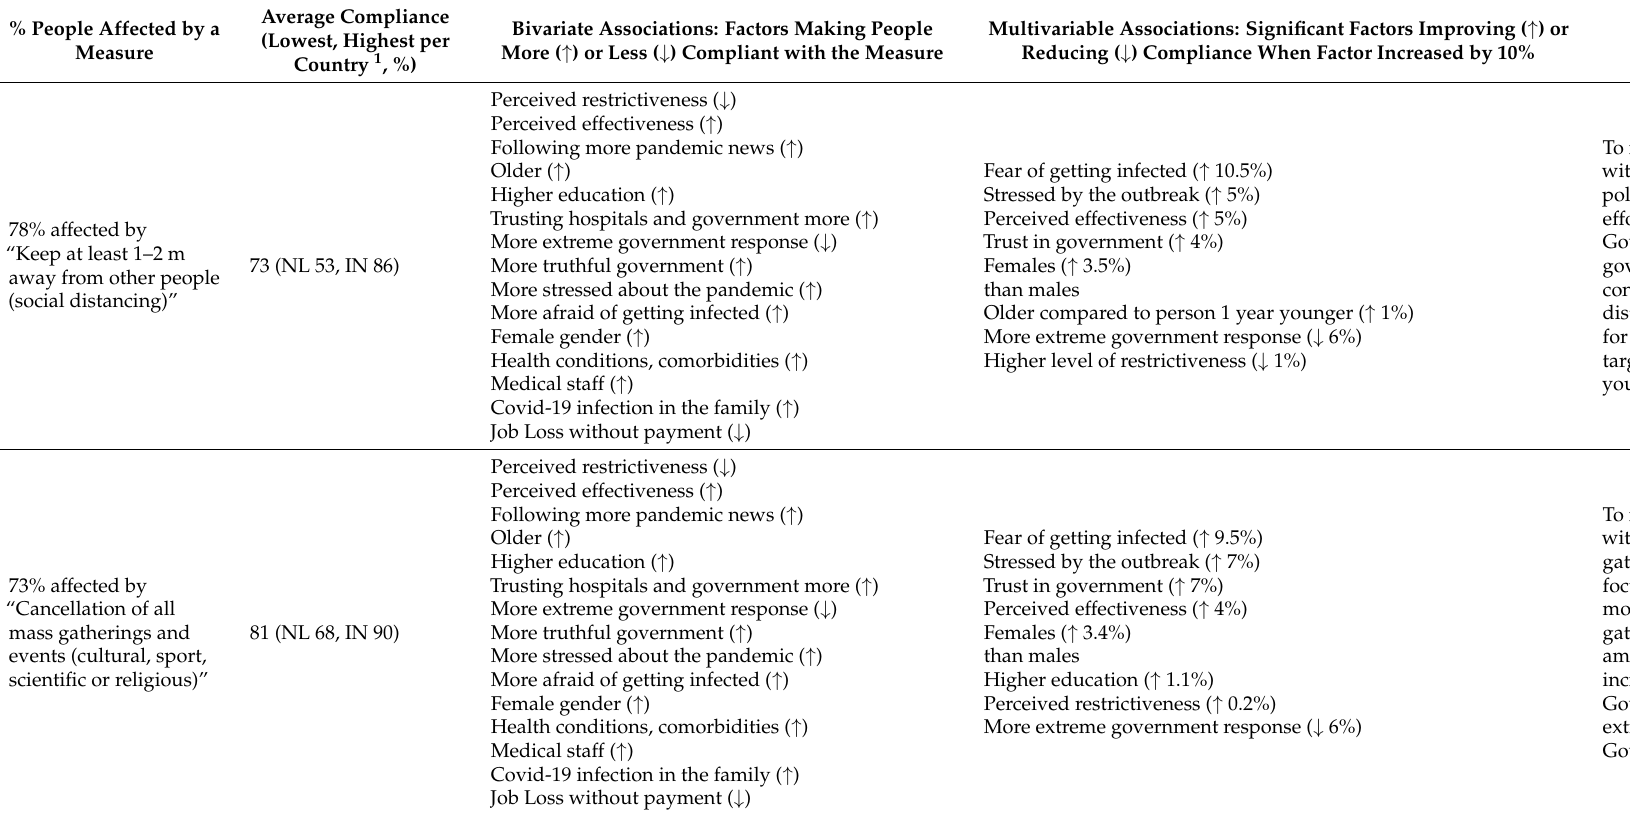
Table 1. Compliance with the five most relevant measures for citizens’